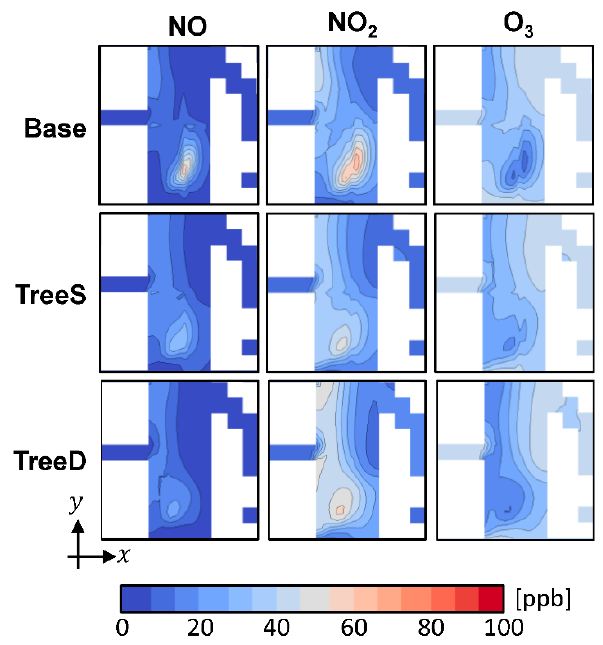
Figure 10. Pollutant concentrations at 12:00 at 3.0 m height for each case. Vertical profiles of the velocity magnitude in the Base, TreeS, and TreeD cases are shown in Figure 11. The tree canopy almost always weakened the wind in the canyon. In addition, larger LAD values led to more significant